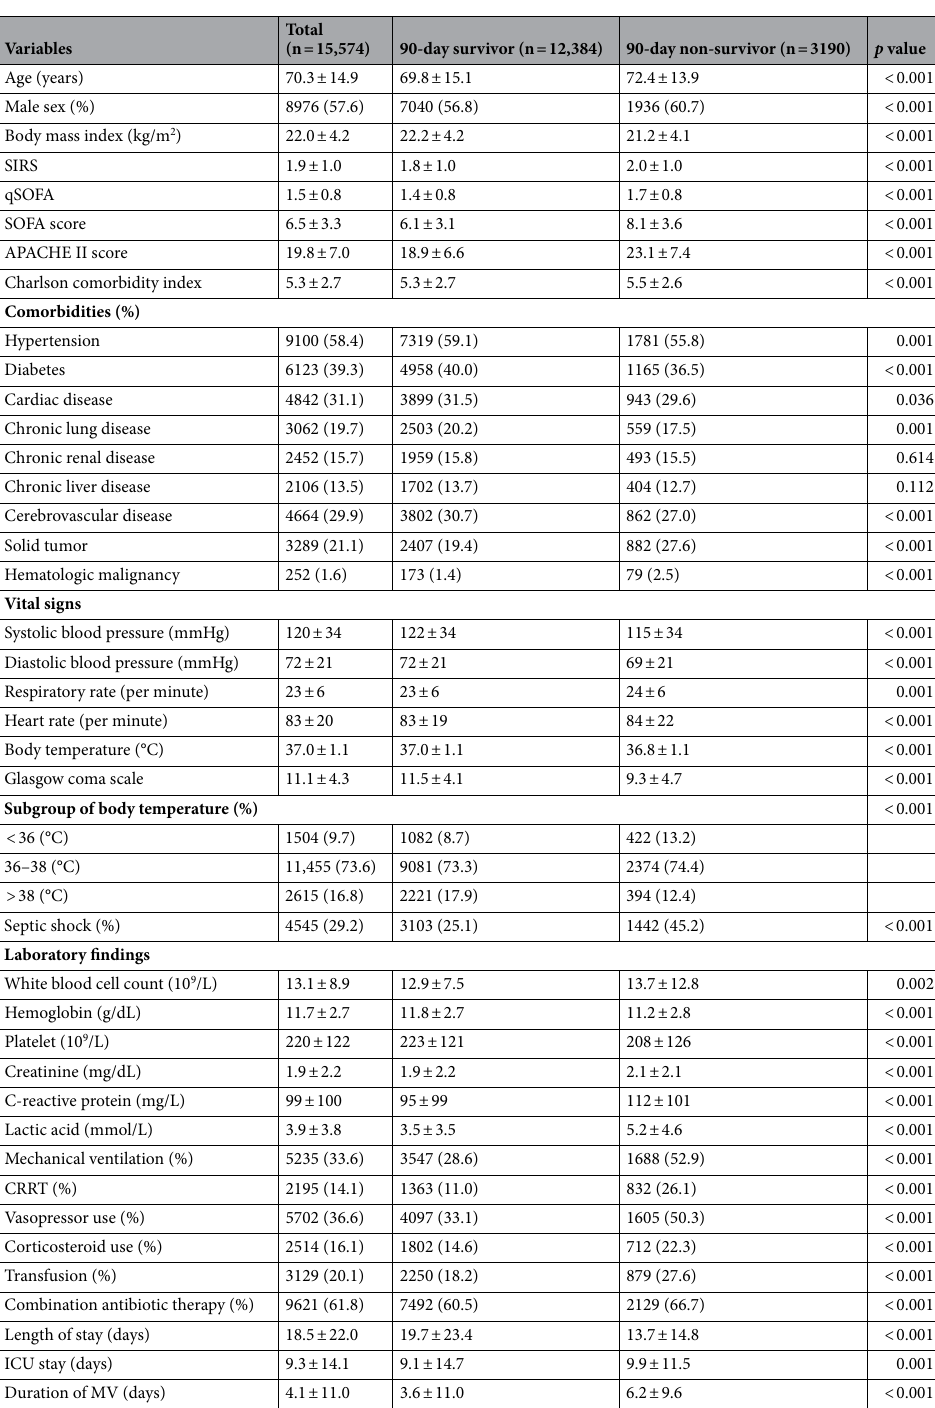
Table 1. Baseline characteristics of sepsis patients according to mortality. Values are presented as mean ± SD, or n (%). SIRS, systemic inflammatory response syndrome; SOFA, sequential organ failure assessment; APACHE, acute physiology and chronic health evaluation; CRRT, continuous renal replacement therapy; ICU, intensive care unit; and MV, mechanical